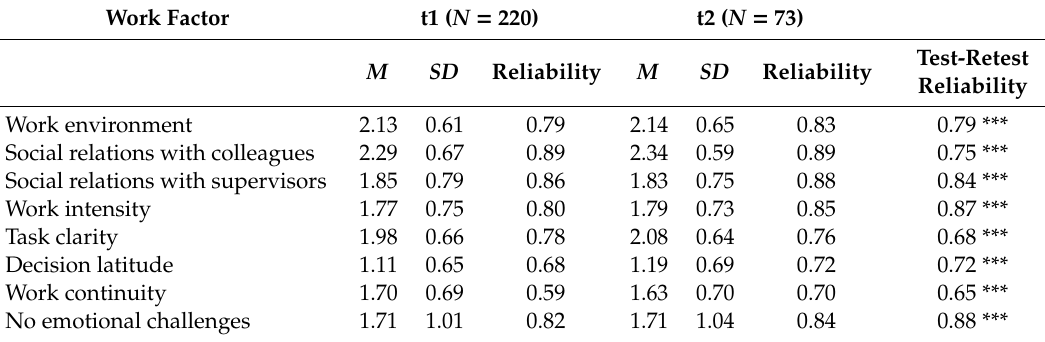
Table 3. Descriptive values and test-retest